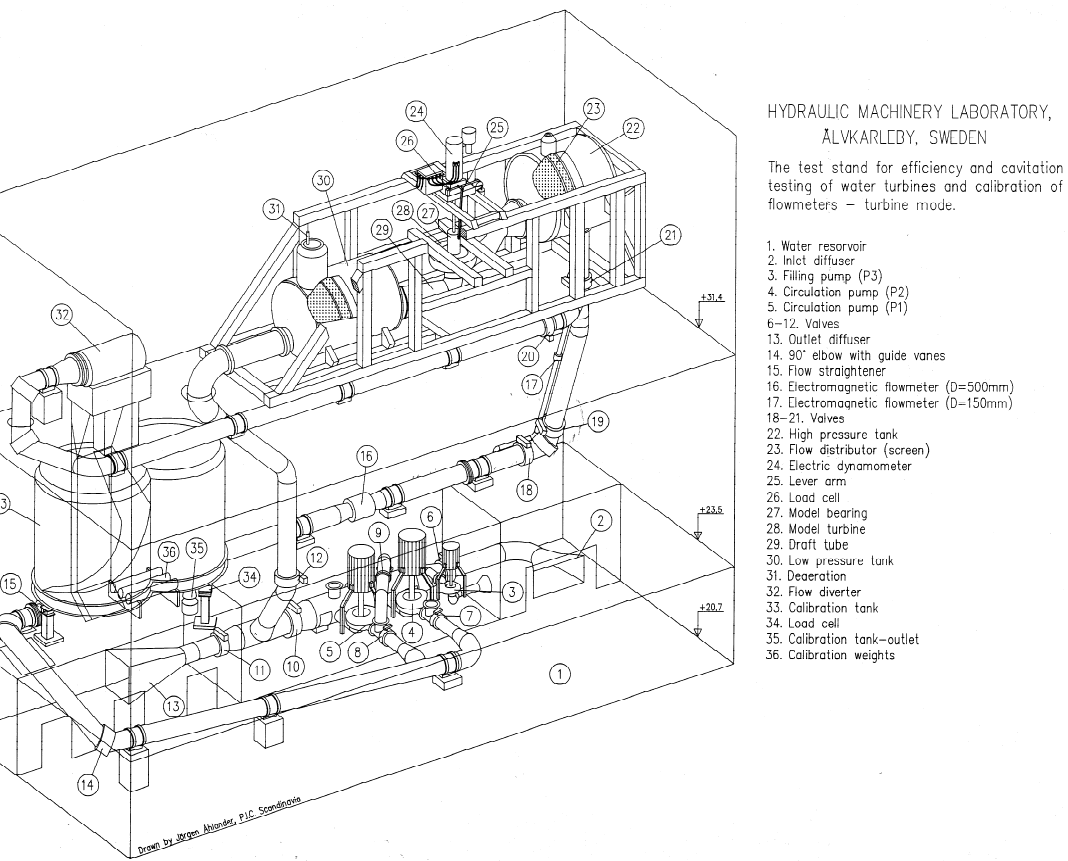
Figure 2. Schematic of the test stand.